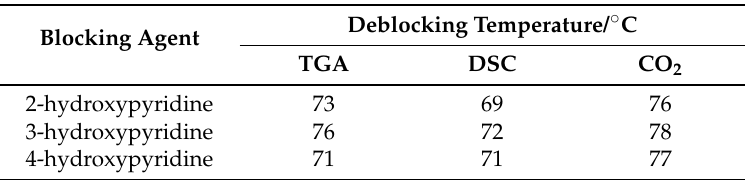
Table 1. Deblocking temperatures of blocked isocyanates